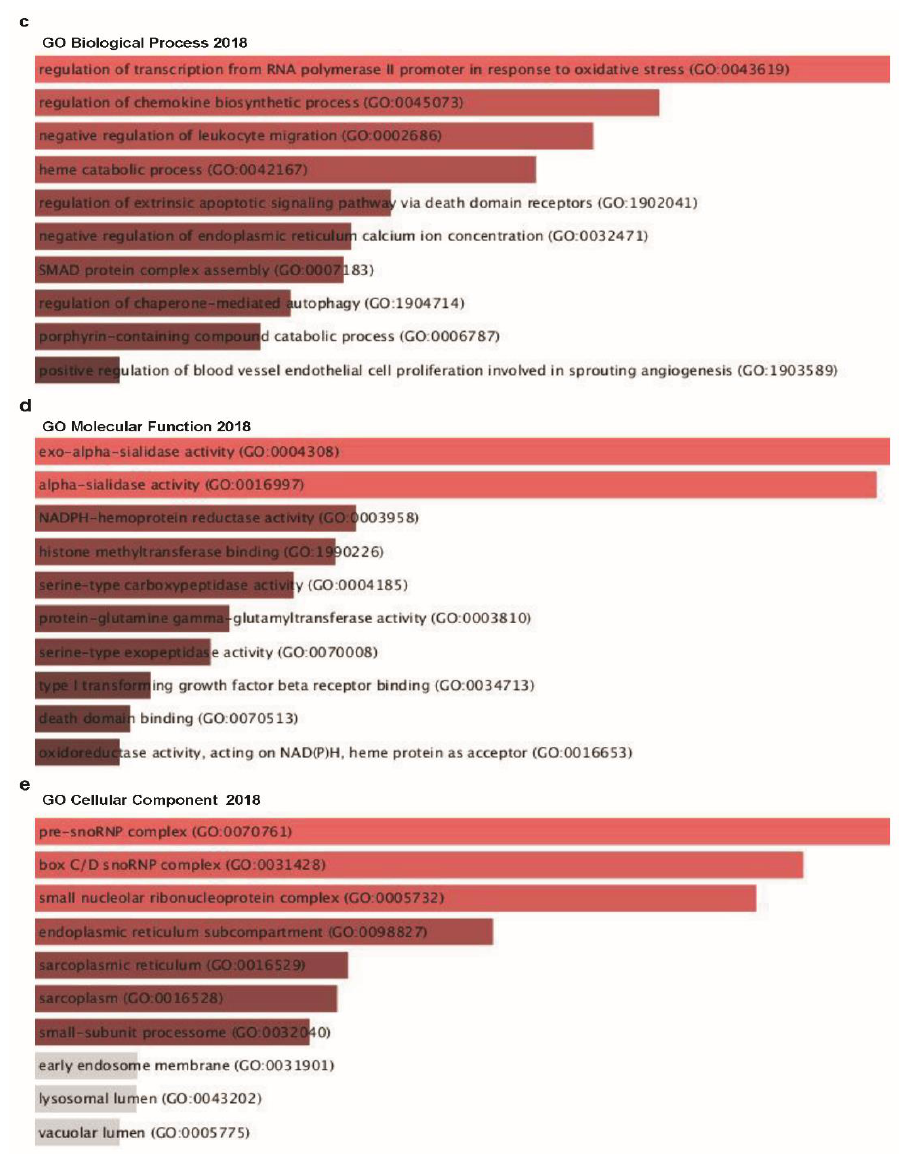
Figure 8. Co-expressed genes profile with the TTYH3 gene involved in signaling pathways in GC / SC: Enrichr Bar Graph data were collected from Enricher web (https: // amp.pharm.mssm.edu / Enrichr). This figure depicts the results showing the gene ontology (GO) and signaling pathways of TTYH3 and the positively correlated genes in gastric cancer. ( a ) The bar graphs represent genes positively correlated to TTYH3 , showing the involvement in GC / SC; pathway analysis was done using Enricher (REACTOME pathways 2016). ( b ) Kyoto Encyclopedia of Genes and Genomes (KEGG) pathways 2019. ( c ) Enrichment of GO Biological Process (2018) terms in proteomic analysis. ( d ) Enrichment of GO Molecular Function (2018) terms in proteomic analysis. ( e ) Enrichment of GO Cellular Component (2018) terms in proteomic analysis. The bar graph represents the ratio of the percent composition of terms in proteomic data vs. percent composition in the genome annotation. The length of the bar represents the significance of that specific gene-set or term. The brighter the color, the more significant that term is.